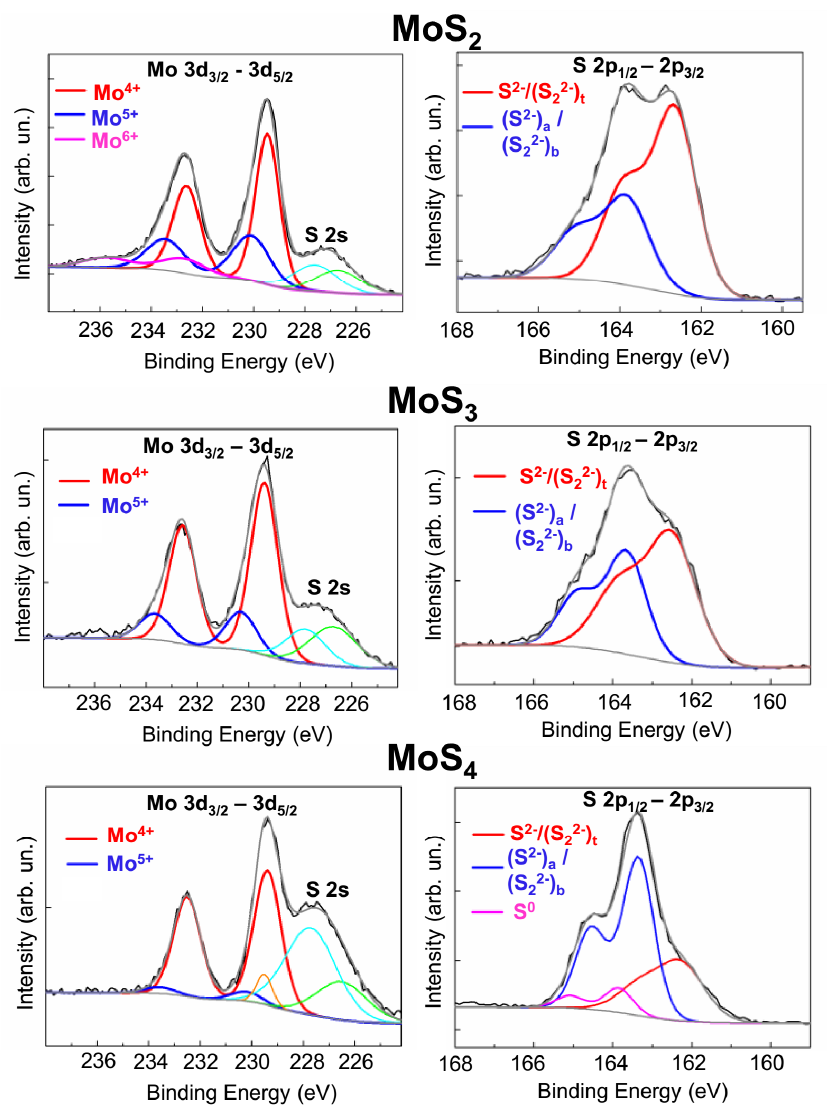
Figure 4. XPS spectra of Mo 3d and S 2s, measured on the surfaces of MoS 2 , MoS 3 , and MoS 4 coatings.